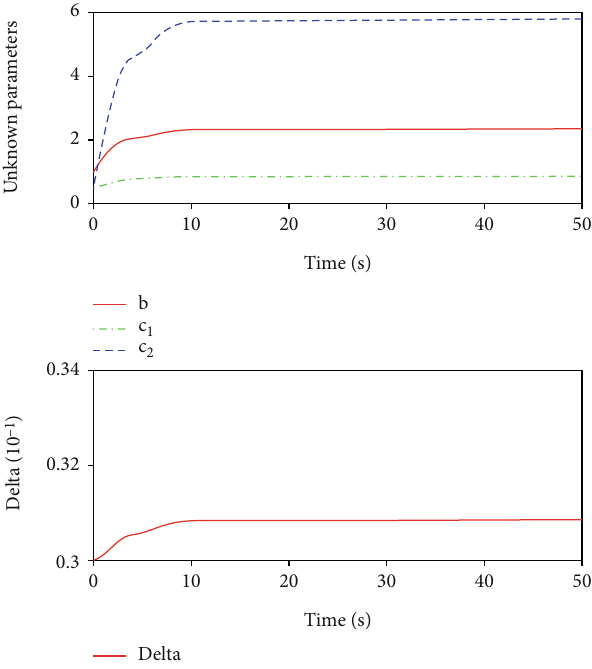
Figure 3: Time response of estimating unknown parameters and controller